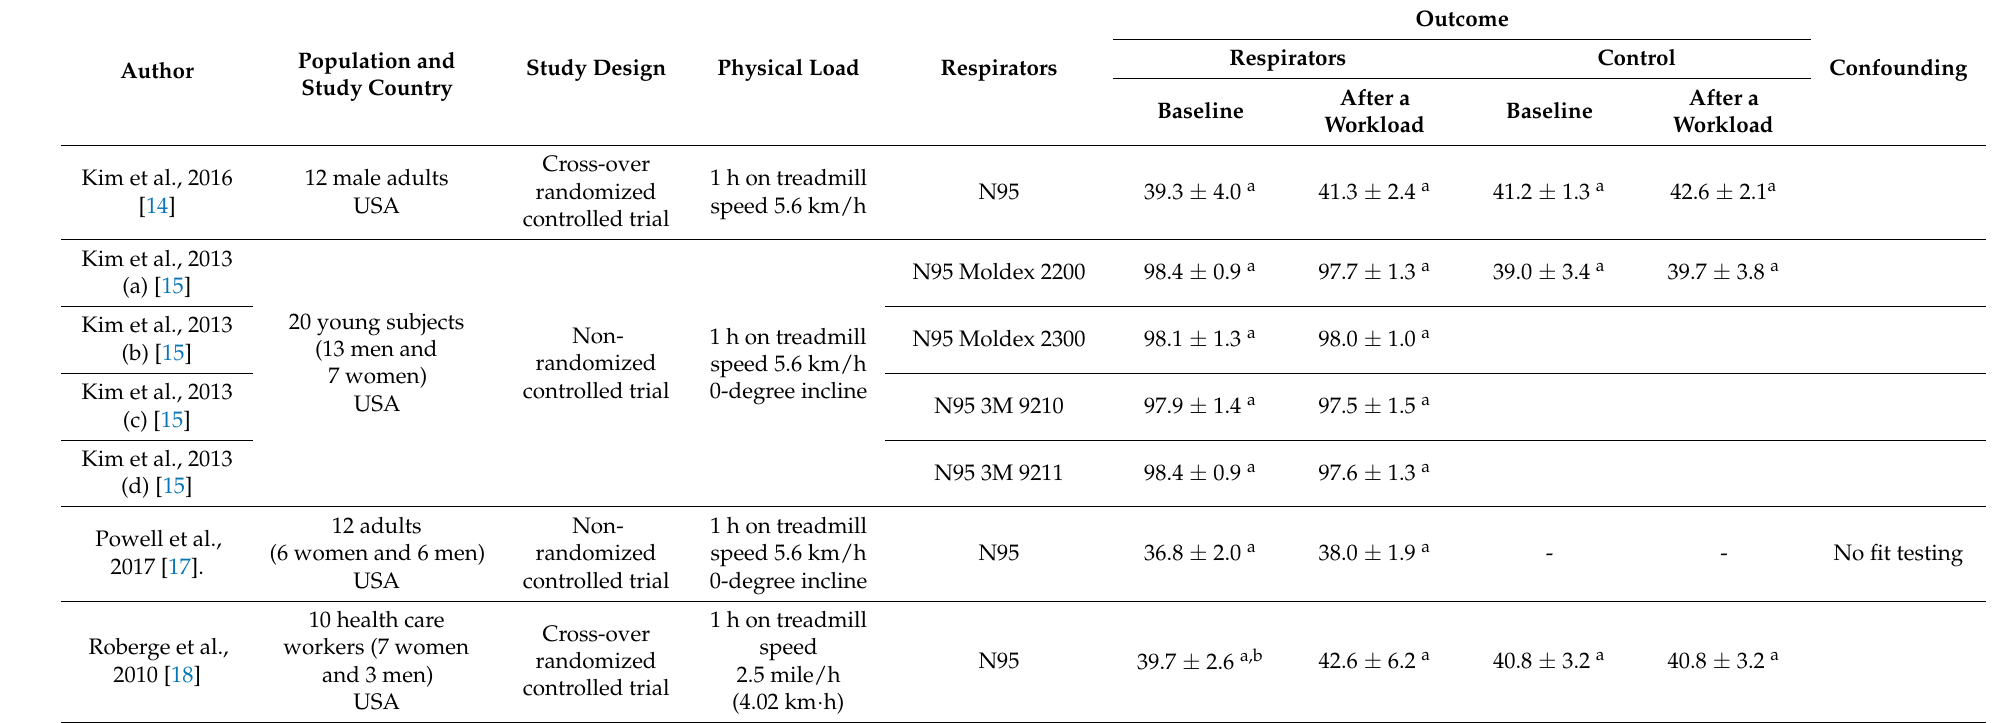
Table 4. Partial Pressure of Carbon Dioxide in Low-Moderate Physical